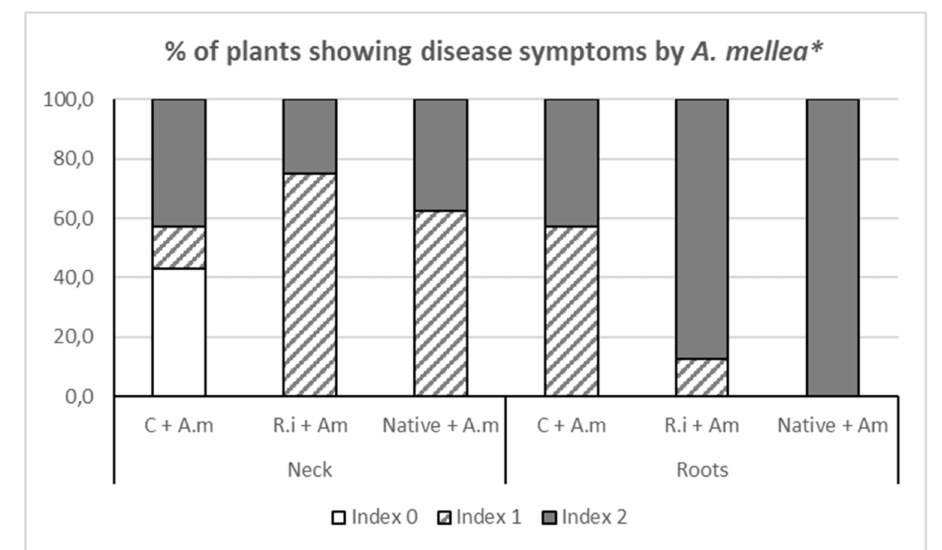
Figure 2. White root rot Armillaria mellea (Am) disease symptoms in the roots and crown of the loquat ( Eriobotrya japonica) plants with Rhizoglomus irregulare ( R.i ), the native AMF or non-inoculated control plants (C), twelve months after inoculation with the pathogen. * Disease symptoms: Index 0: no symptoms, Index 1: low-level necrotic tissue, Index 2: high-level necrotic tissue with mycelium. Data are percentages of plants per treatment showing the disease symptoms described.